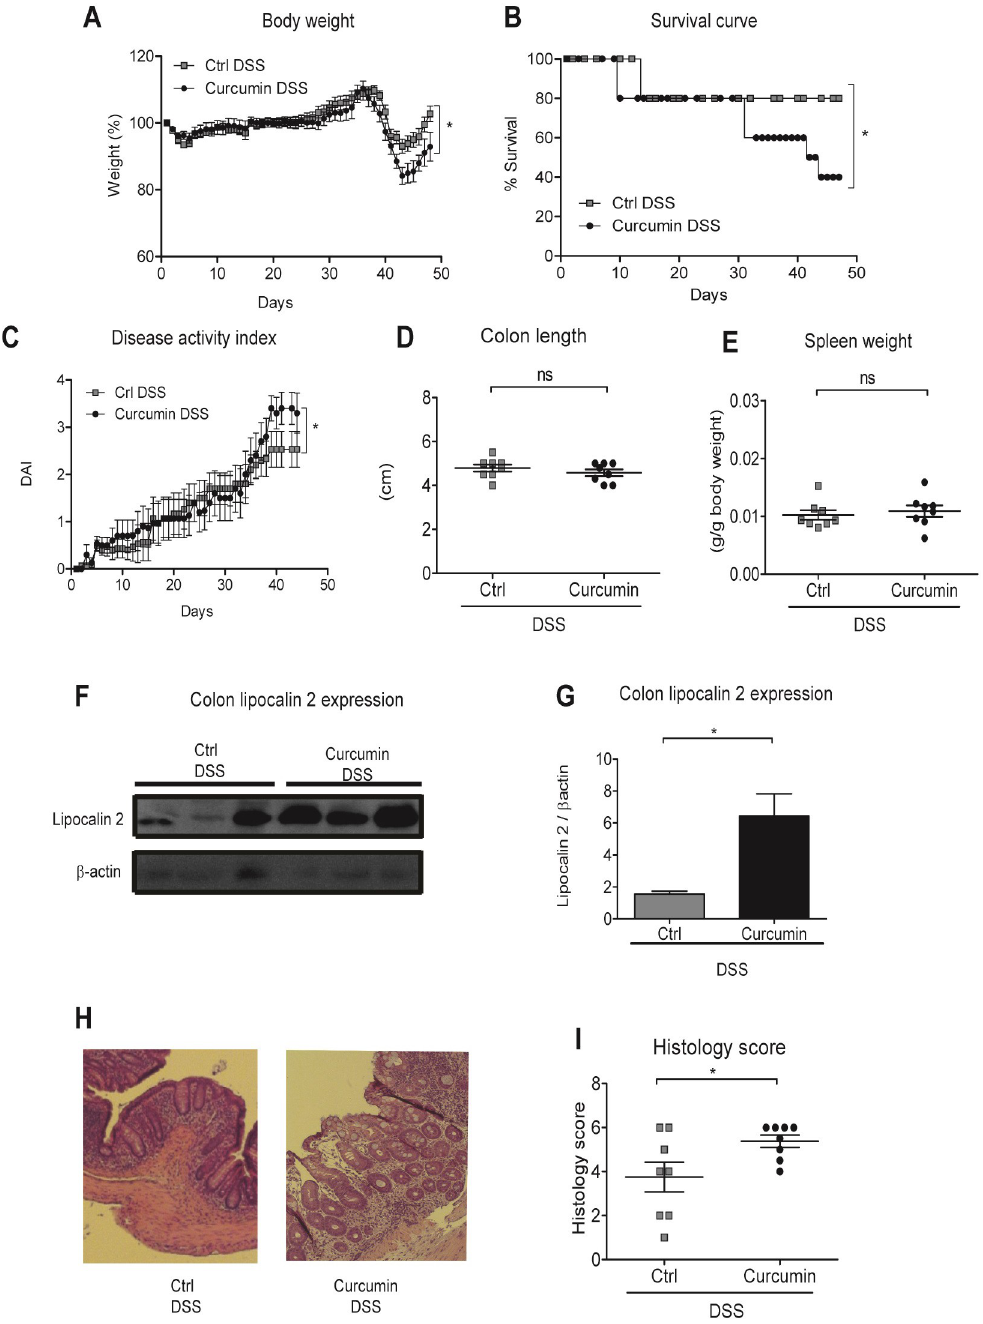
Fig 5. Curcumin supplementation of an iron-sufficient diet in BALB/C mice exacerbates DSS-induced colitis. BALB/c mice were fed an iron-sufficient diet (50 mg/kg chow; Ctrl) or iron-sufficient diet supplemented with 2% curcumin (Curcumin) starting at 2 weeks before administration of dextran sodium sulfate (DSS). (A) Body weight. (B) Survival. (C) Disease activity index (DAI). (D) Colon length. (E) Spleen weight. (F-G) Colonic lipocalin 2 expression. (F) Representative western blot of colonic lipocalin 2 and β -actin expression. Each lane represents an individual mouse. (G) Graphic depicting densitometric quantification of western blots from three independent experiments. Data are presented as mean ± SEM. (H) Representative hematoxylin and eosin staining of mouse colon histological section. (I) Graphic depicting quantification of colonic histology scores. Results are representative of a minimum of three independent experiments; n = 8 mice per group. Statistical analysis was performed by two-tailed Student’s t -test. � P < 0.05; ns = not significant.